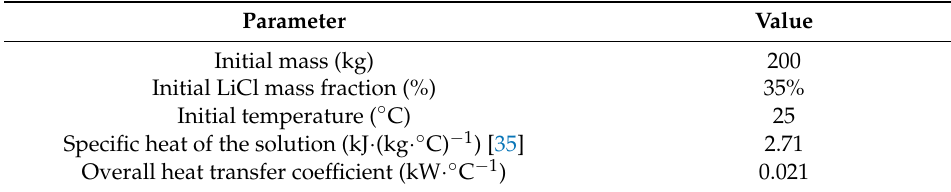
Table 3. Specifications of the liquid desiccant